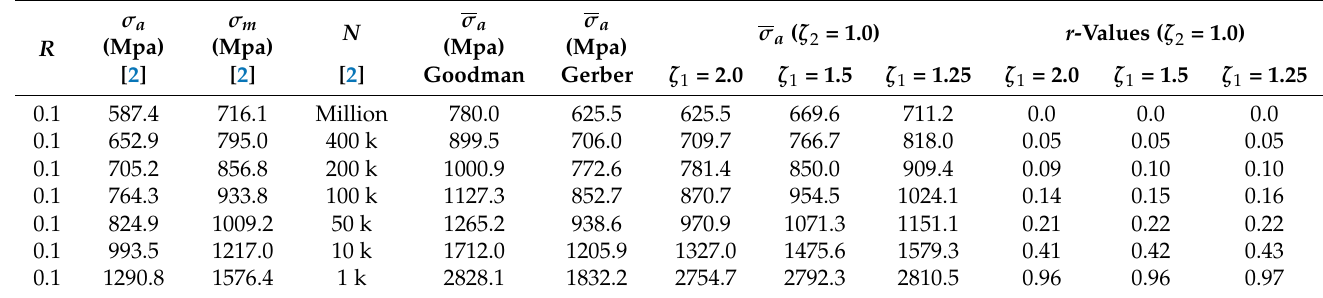
Table 3. The σ a values obtained using various combinations of σ m and σ a .